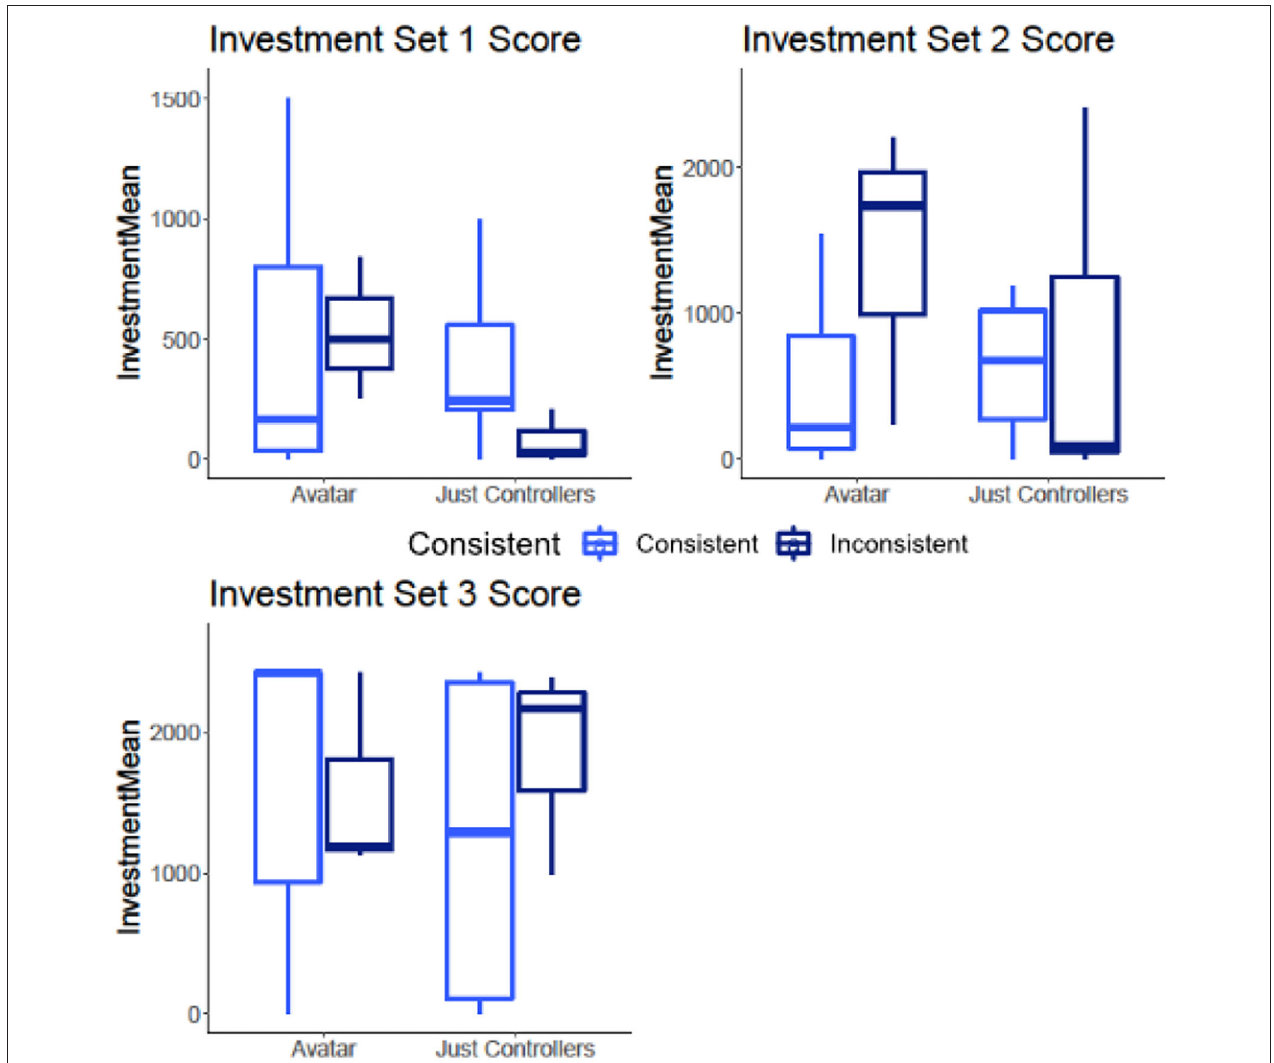
FIGURE 6 | Study 2: boxplots of sets of DayTrader game investments.